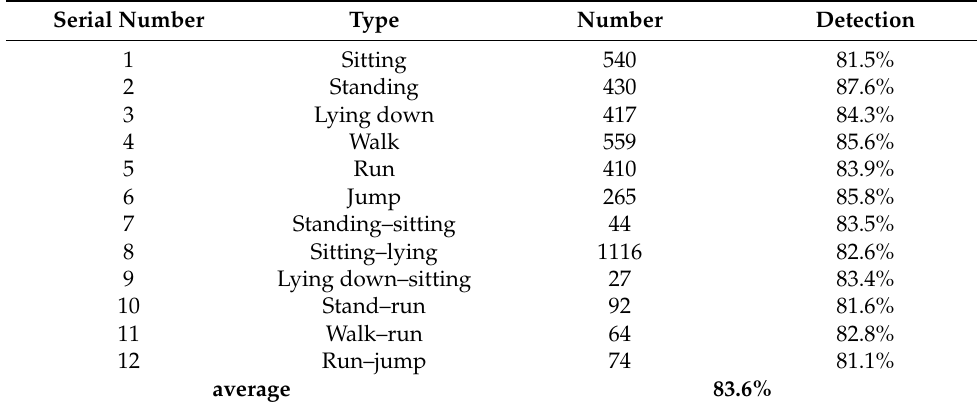
Figure 28. ( a ) SPSS statistical chart of the detection results after the improved machine learning algorithm ( b ) SPSS statistical chart of the detection results after the improved machine learning algorithm. Table 9. The improved human behavior detection data statistics table.